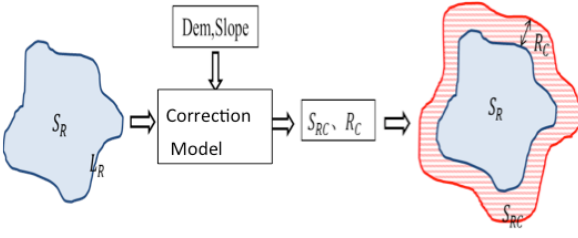
Figure 1. Updating procedure in the region with original residential area